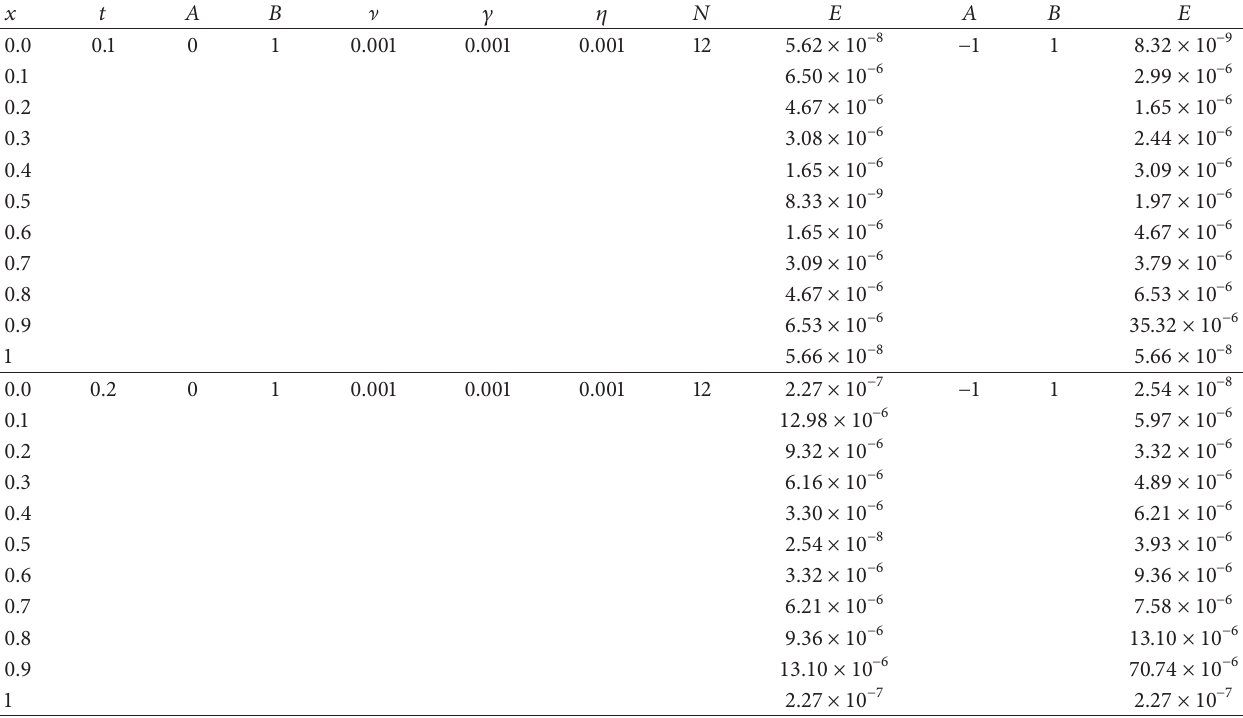
Table 3: Absolute errors with 𝛼 = 𝛽 = 1/2 , 𝛿 = 3 and various choices of 𝑥,𝑡 for Example 1.